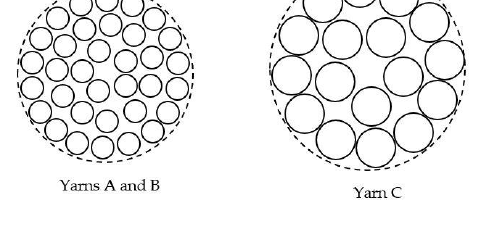
Figure 1. Yarns' structures.